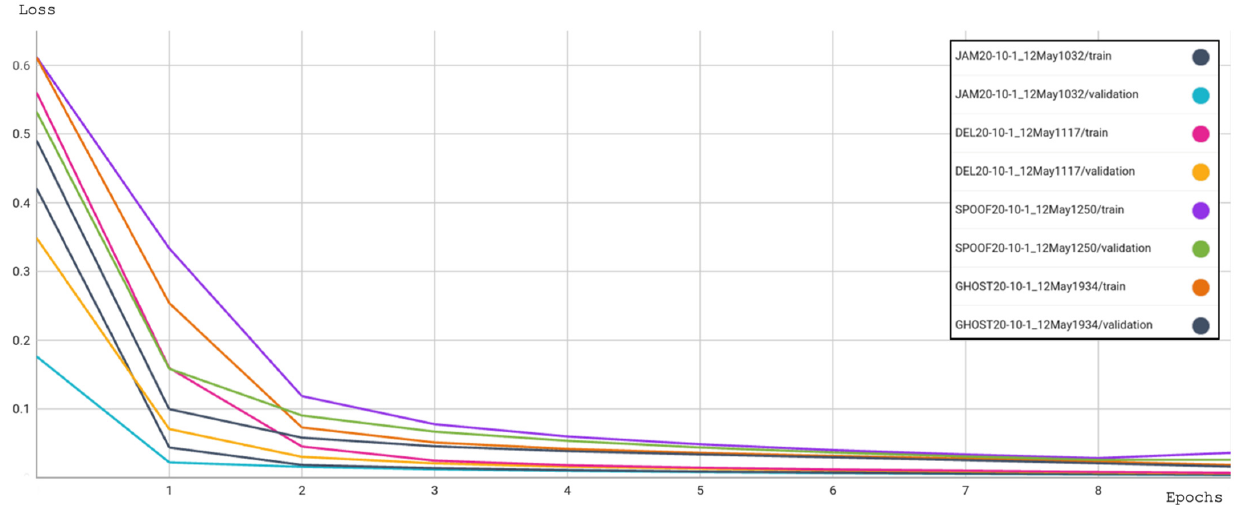
Figure 11. Cyberattacks: model loss.